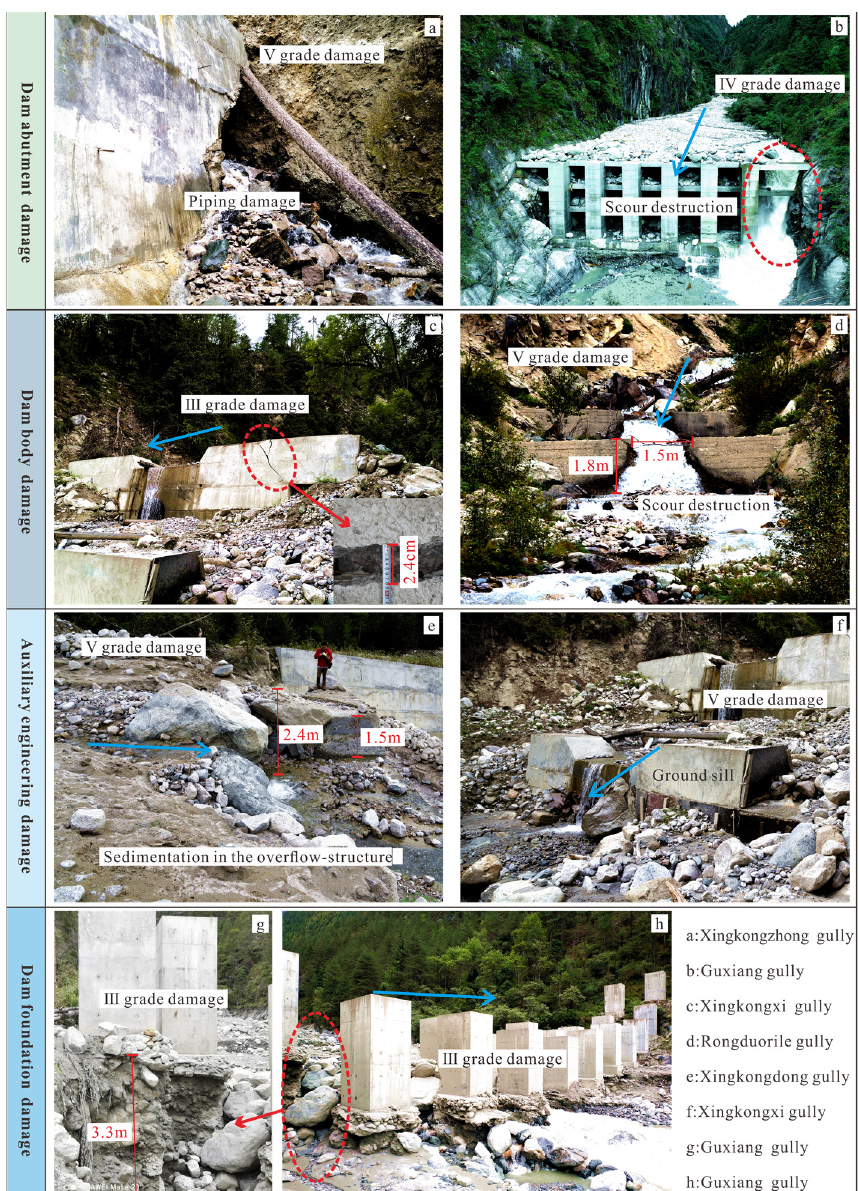
Figure 4. Damage types for check dams subject to glacial debris flow.